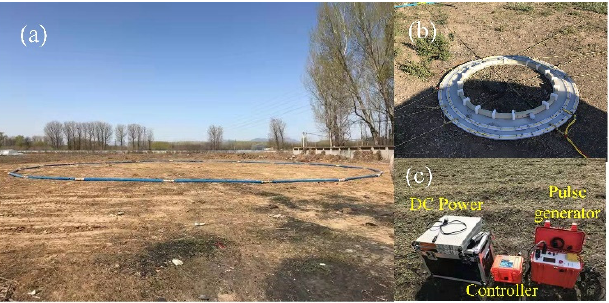
Figure 15. ( a ) The LF circular launching frame. ( b ) The proposed bucking structure and LF sensor. ( c ) The DC power supply and PRBS pulse transmitter.